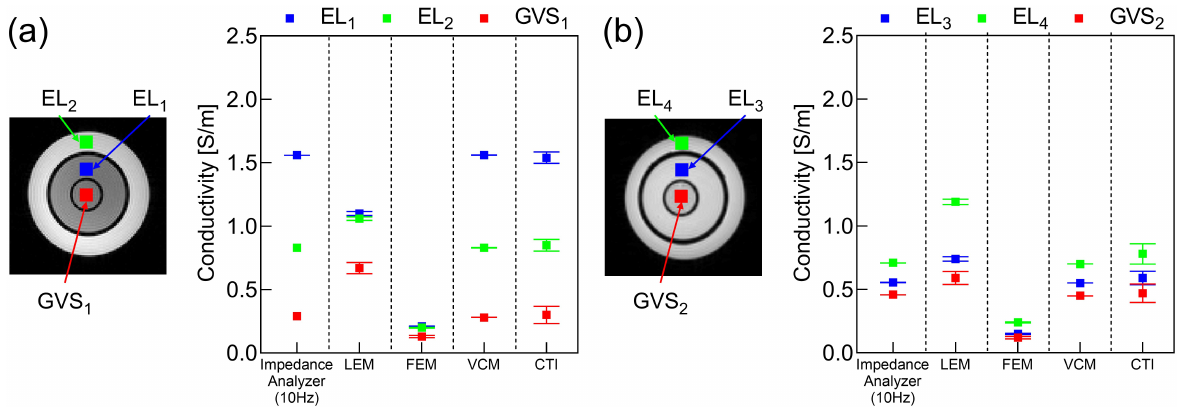
Figure 2. Values of σ L = σ l + σ t 1 + σ t 2 in the reconstructed conductivity tensor images of phantoms #1 ( a ) and #2 ( b ). The 3 values were compared with the conductivity values measured at 10 Hz using the impedance analyzer. The square symbol indicates the mean value and the bar represents the